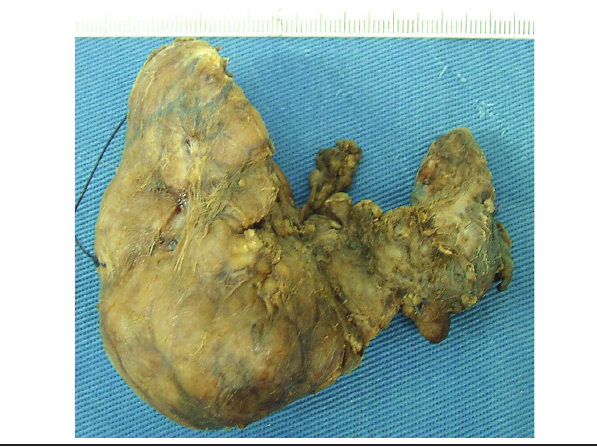
FigurE 4 − Thyroid (HE, 100×): adipose metaplasia and oxyntic cells HE: hematoxylin and